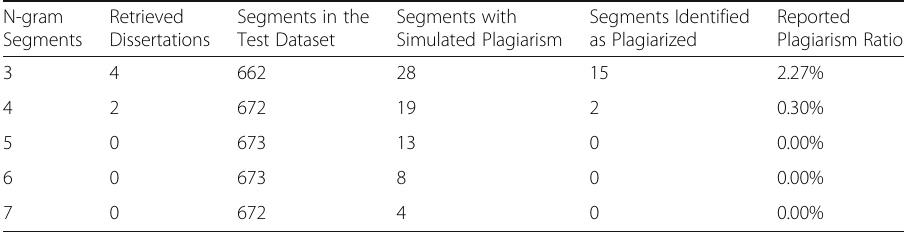
Table 17 Results of experiment III where the dataset is injected with plagiarism-simulated sentences and run against the subcorpus